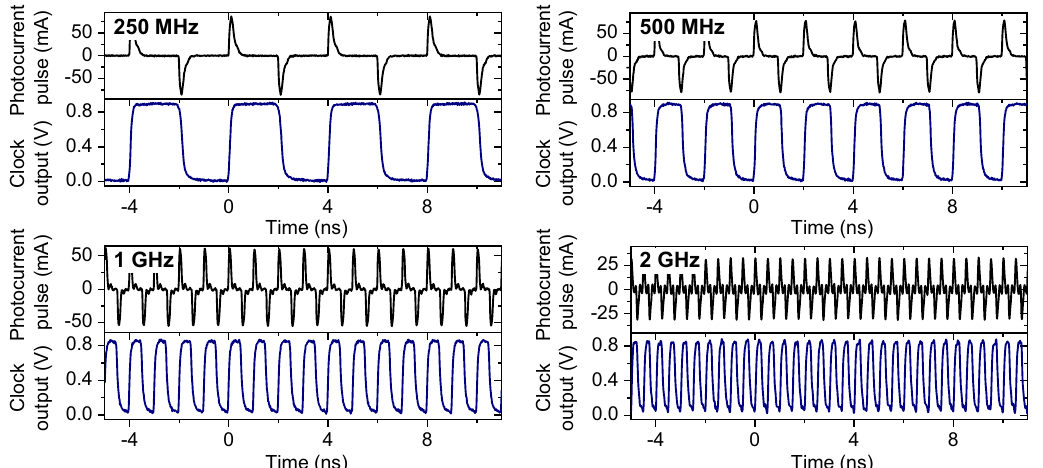
Fig. 2 | Resulting waveforms at different clock rates. Photocurrent pulse wave- formsfromtheBPD(toppanels)andoutputdigitalclocksignalwaveforms(bottom panels),whichweremeasured independently,atclockrates of 250MHz, 500MHz,